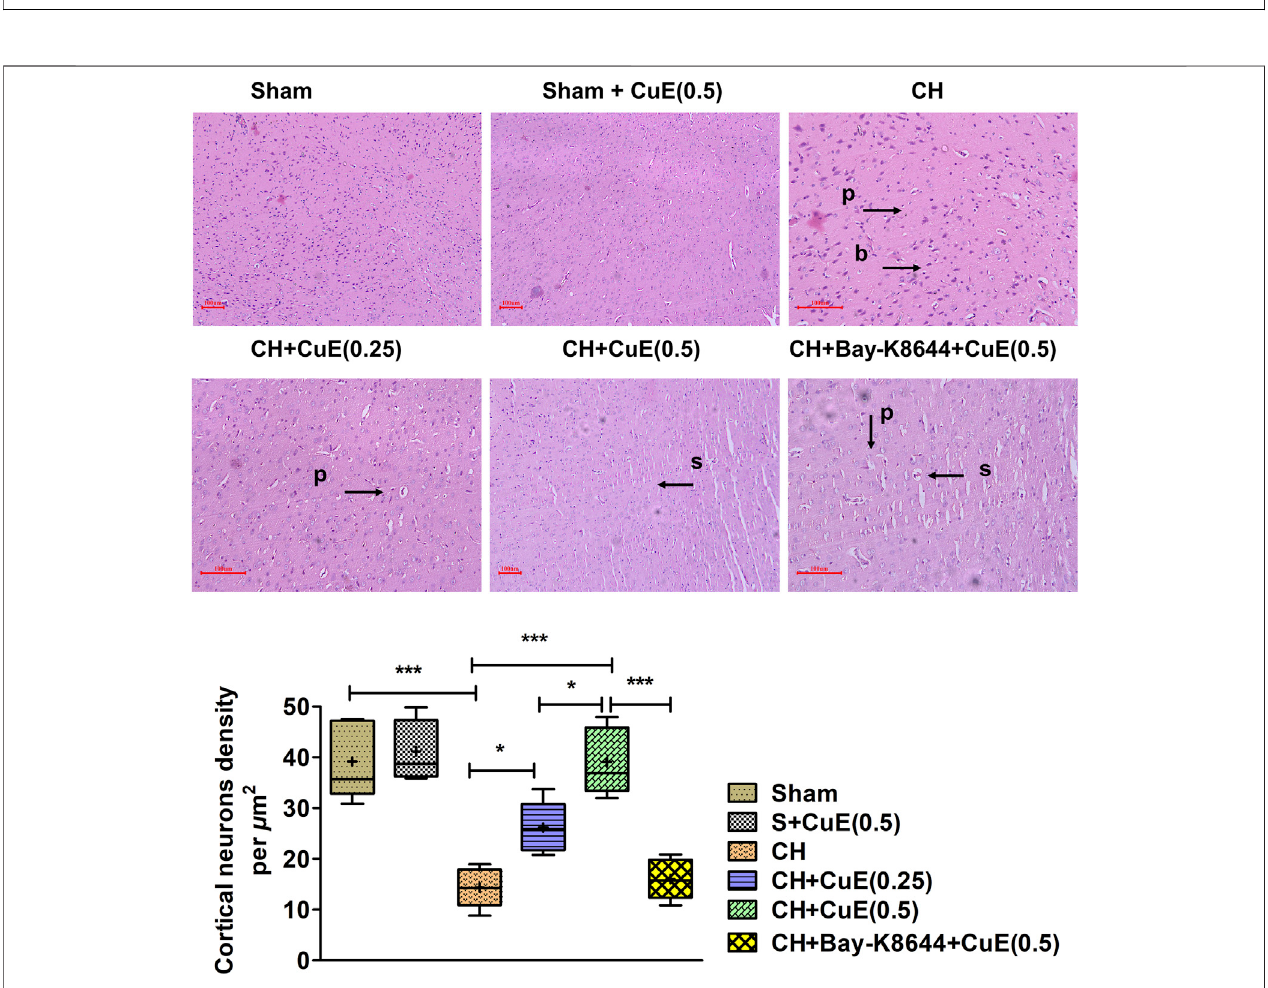
FIGURE 8 | CuE, 0.25 and 0.5 mg/kg, p.o. , attenuated CH triggered neurodegenerative changes in the cortical regions ( n (cid:1) 5) (H & E stain, × 40, scale 100 µm). Pyknosis (p), bulging of plasma membrane (b), and swelling (s) were observed. Histomorphometric determinations indicate cortical neuron density per µm 2 . Box and whisker plots (Tukey) show mean (+), median (bold horizontal line), quartiles (box), and total range (whisker) ( n (cid:1) 5). * p < .05, ** p < .01, *** p < .001